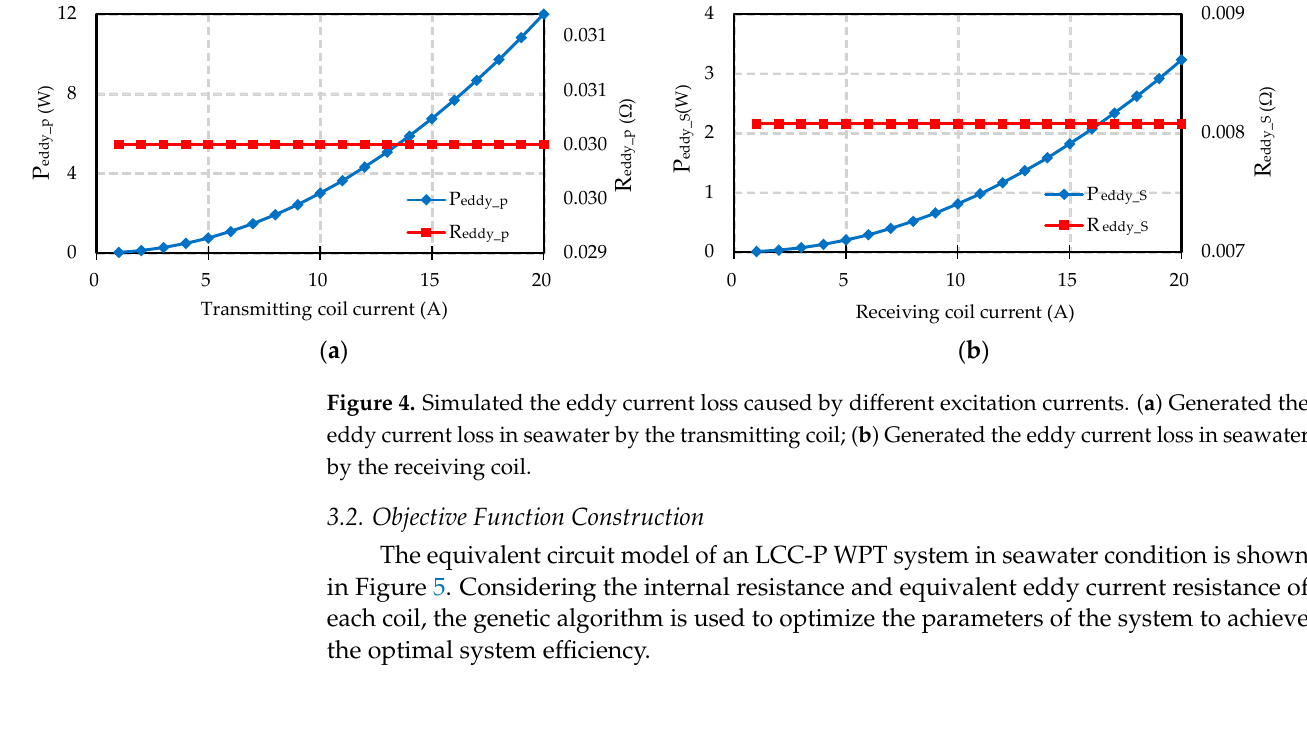
Figure 4. Simulated the eddy current loss caused by different excitation currents. ( a ) Generated the eddy current loss in seawater by the transmitting coil; ( b ) Generated the eddy current loss in sea- water by the receiving coil. 3.2. Objective Function Construction